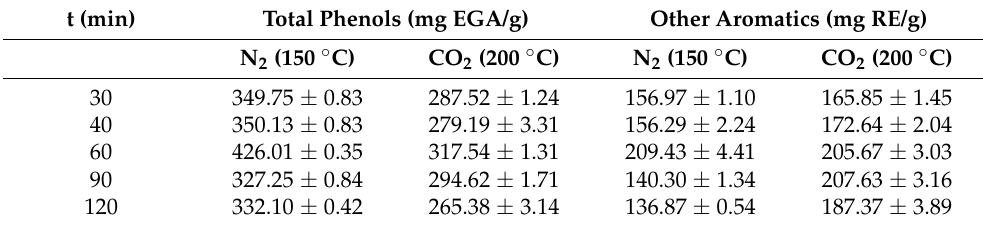
Table 3. The influence of time on lignin